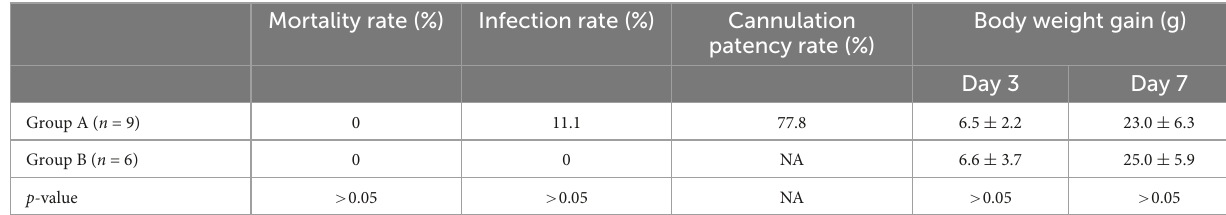
TABLE 1 Outcomes comparison between Group A and Group B.